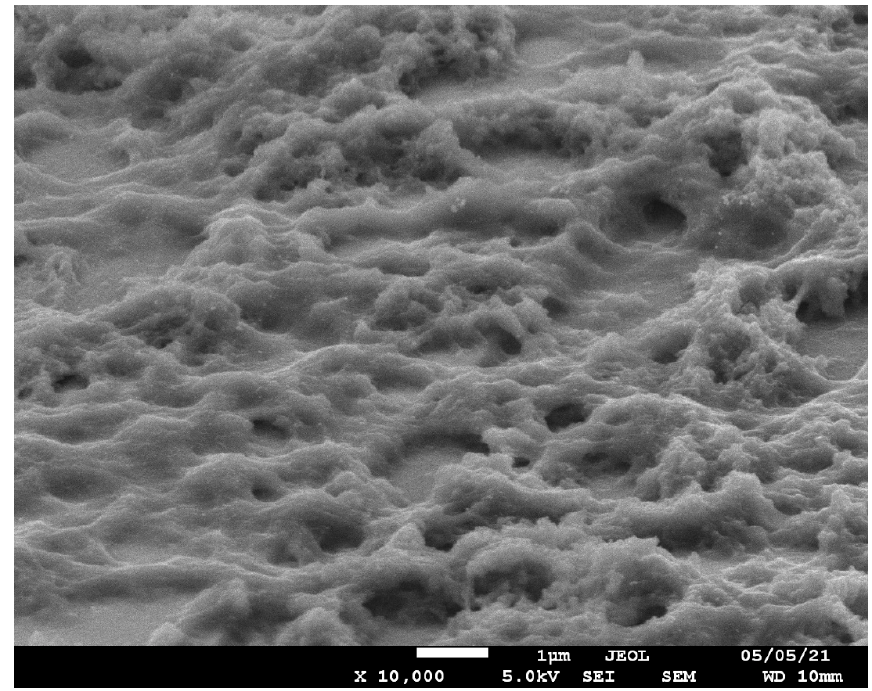
Figure 9. SEM image of poly-[Co(Amben)]-coated interdigitated